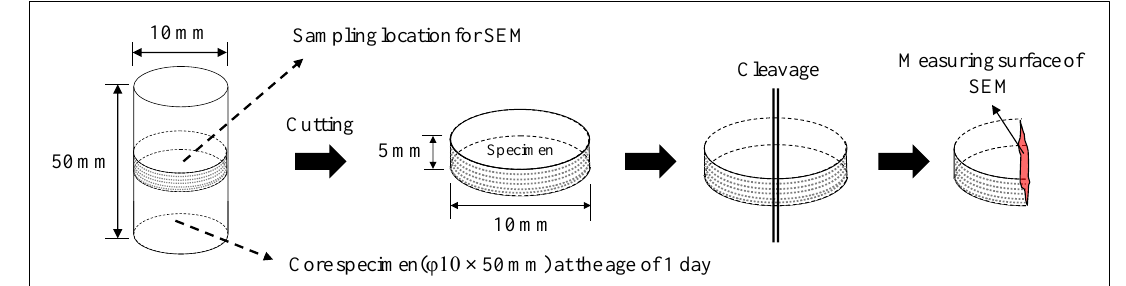
Figure 2. Sampling of specimens for